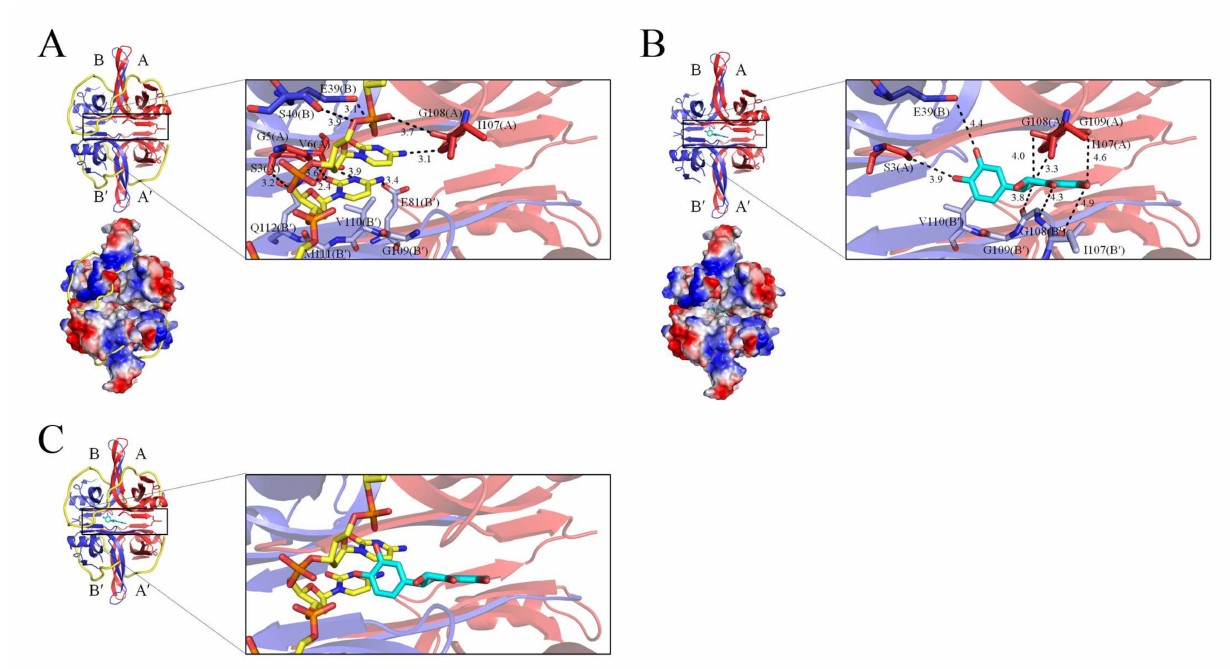
Figure 5. Proposed inhibition mode of taxifolin against SeSSB. ( A ) The ssDNA binding mode of SeSSB. Based on the structural resemblance between SeSSB and EcSSB, their ssDNA-binding modes may be similar. The ssDNA generated from the ssDNA–EcSSB complex (PDB ID 1EYG) is shown in gold in the SeSSB–ssDNA complex. Superposition analysis indicates that residues S3(A), G5(A), V6(A), I107(A), G108(A), E39(B), S40(B), E81(B (cid:48) ), G109(B (cid:48) ), V110(B (cid:48) ), M111(B (cid:48) ), and Q112(B (cid:48) ) might be involved in ssDNA binding at the dimer–dimer interface of the SeSSB. ( B ) The proposed taxifolin binding site. Because of the similarity, taxifolin might bind a site similar to that of quercetin. We manually constructed a binding model of taxifolin to the SeSSB by superimposing the SeSSB structure with the quercetin–PaSSB complex, in which quercetin was replaced by taxifolin. Quercetin and taxifolin might bind to the SeSSB at a similar site, but their binding poses were different. Based on this proposed model, residues S3(A), I107(A), G108(A), G109(A), E39(B), I107(B (cid:48) ), G108(B (cid:48) ), G109(B (cid:48) ), and V110(B (cid:48) ) within the contact distance (<5 Å) might be involved in taxifolin binding. ( C )